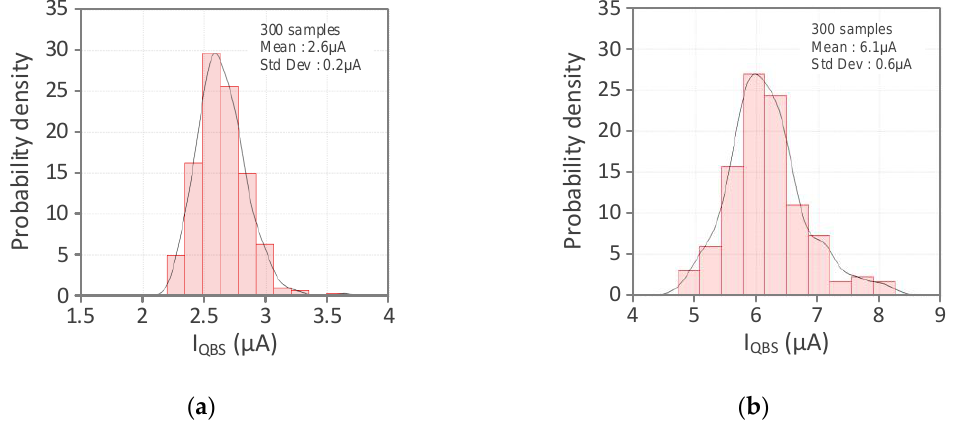
Figure 8. Monte-Carlo simulation results of the quiescent current consumption of proposed high-side UVLO based on the MOS-diode divider with a voltage limiter (Figure 4). ( a ) V BS = 5 V. ( b ) V BS = 20 V.